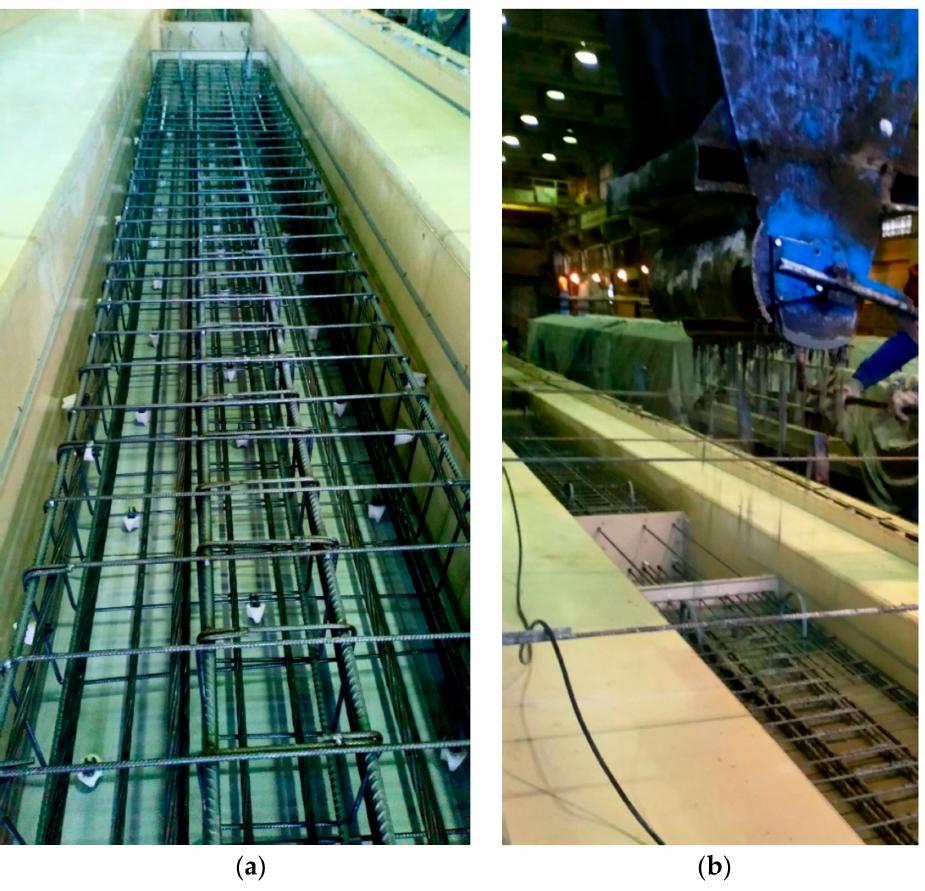
Figure 7. Prepared pretensioned and non-pretensioned reinforcements of experimental beams ( a ), and casting of concrete ( b